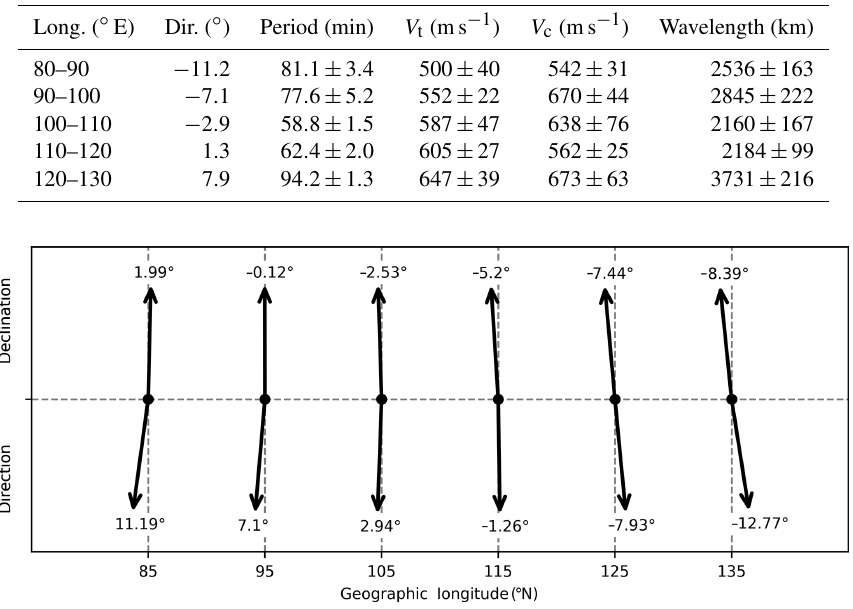
Figure 9. The sketch of (upper) the geomagnetic declination angles and (lower) the propagation directions in different longitudes on the wavefront fitted in Fig. 7. The propagation directions are measured clockwise from the